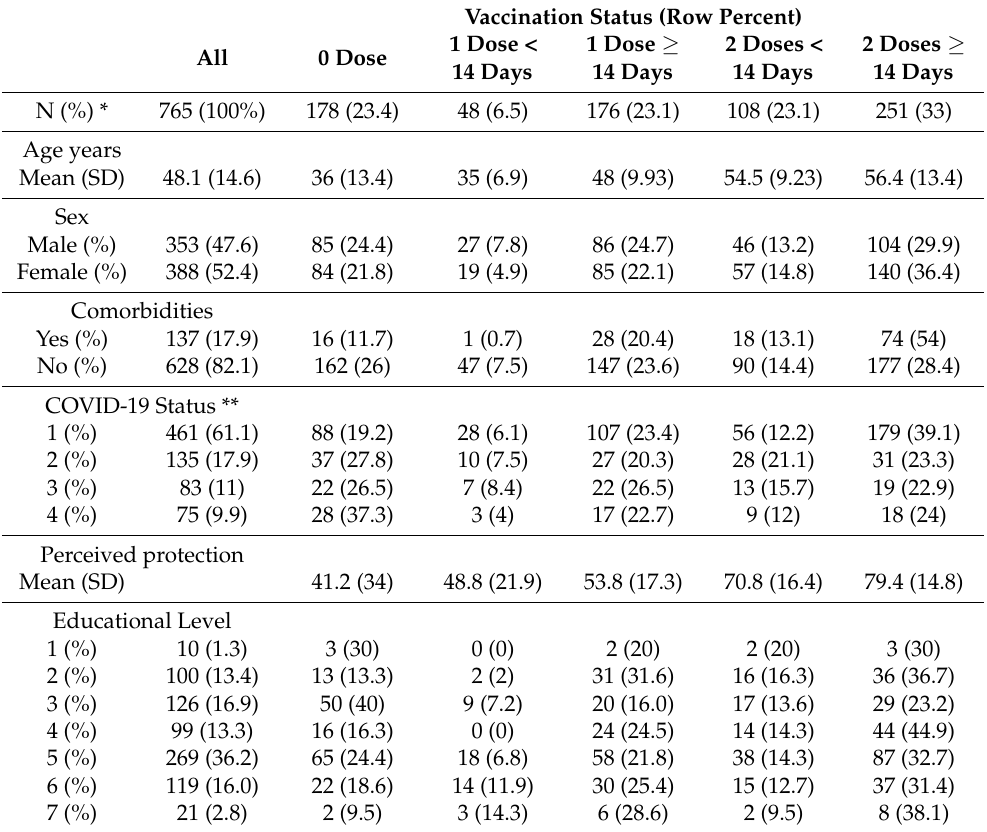
Table 1. Description of the